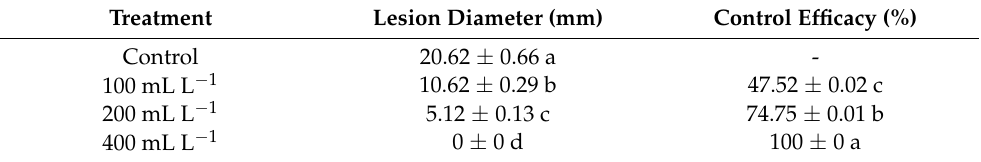
Figure 7. In vivo effects of SFB on kiwifruit disease caused by D. glomerata . Infected kiwifruit treated